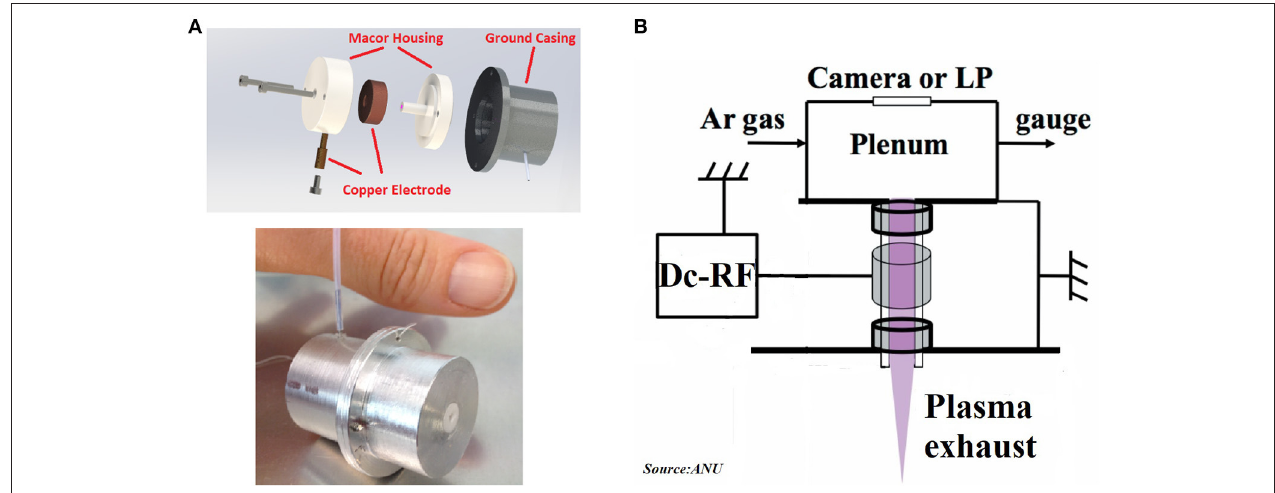
FIGURE 3 | The micro electro-thermal plasma thruster TinyPR developed at ANU. (A) Assembly view of the TinyPR, the smallest Pocket Rocket series electro-thermal micro thruster developed at ANU. (B) Schematics of the TinyPR